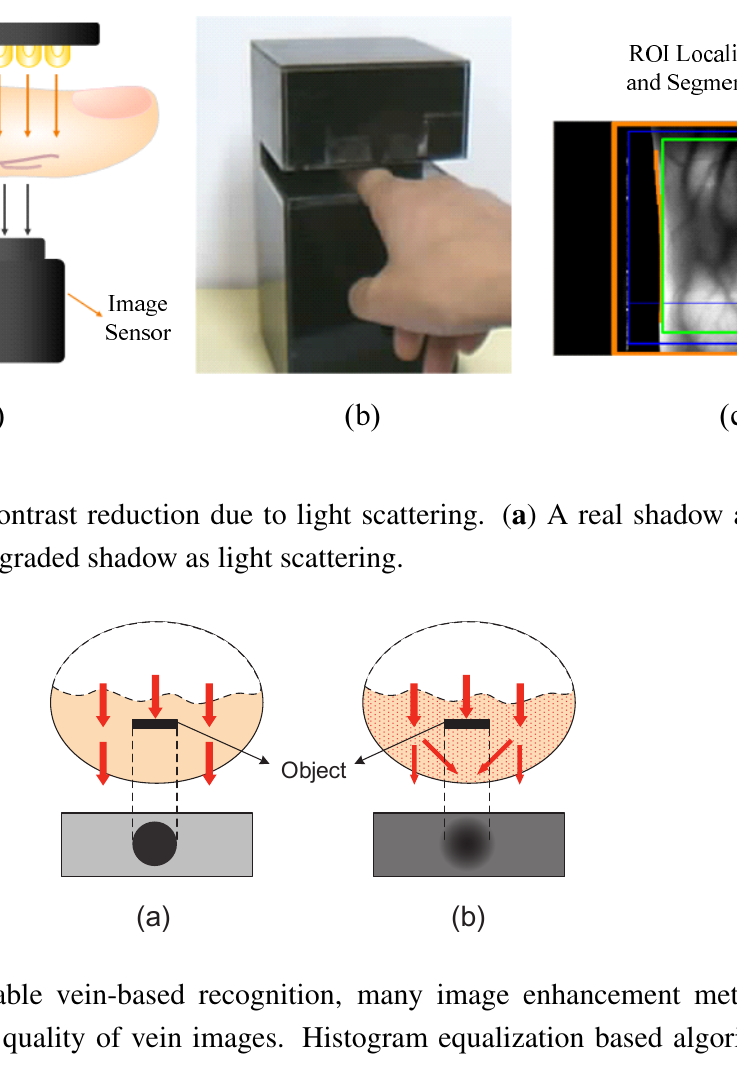
Figure 1. Finger-vein image acquisition system. ( a ) NIR light transillumination. ( b ) A homemade finger-vein imaging device. ( c ) ROI extraction proposed in [4].